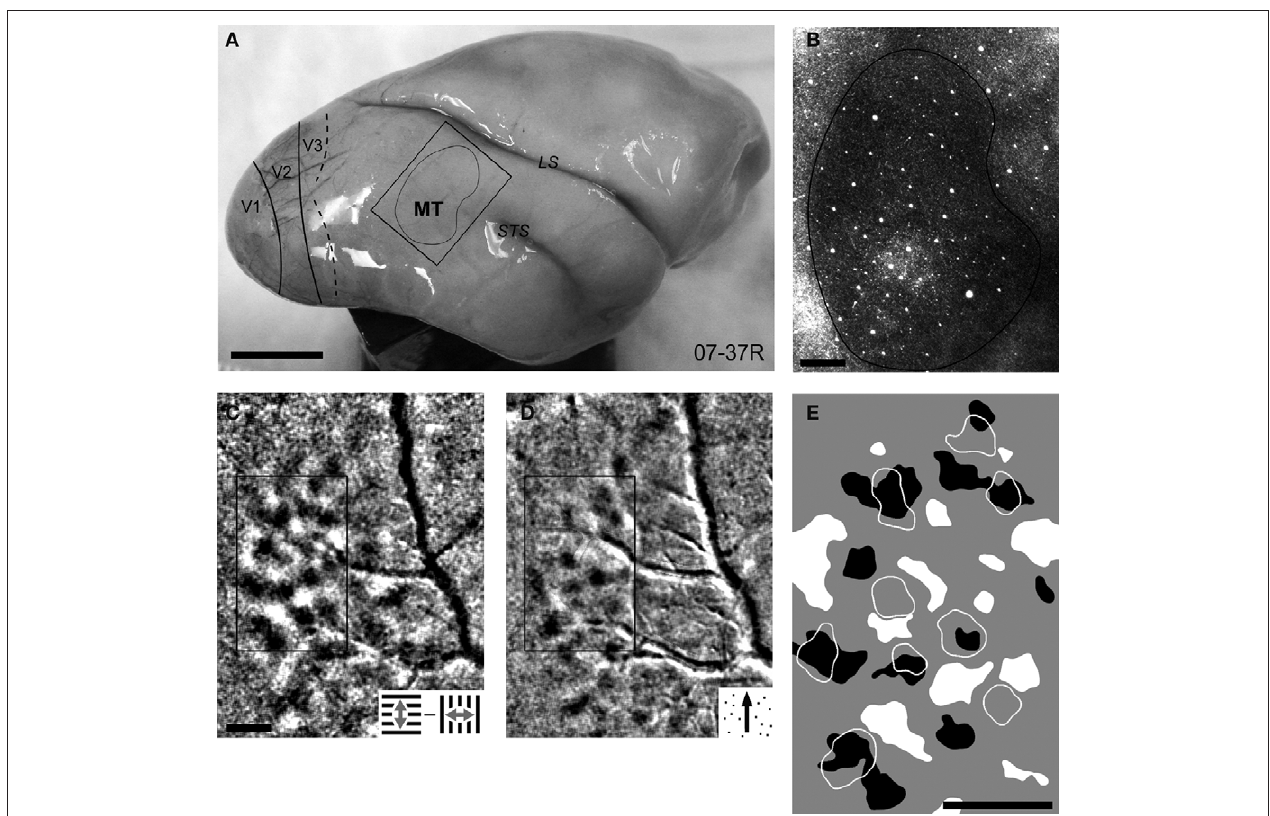
taken from the representation of central vision in MT is indicated with a thin black line in (C,D) . This region represents about 20 ° . (e) The thresholded (see Materials and Methods) optical imaging maps from the ROI in (C,D) . Black regions indicate horizontal “orientation” domains, white regions indicate vertical “orientation” domains. The regions outlined in white indicate the up-direction domains. Note that the up domains enclose only portions of horizontal (black) domains, which moved up and down. Scale bar in (A) : 5 mm. Scale bar in (B–e) : 1